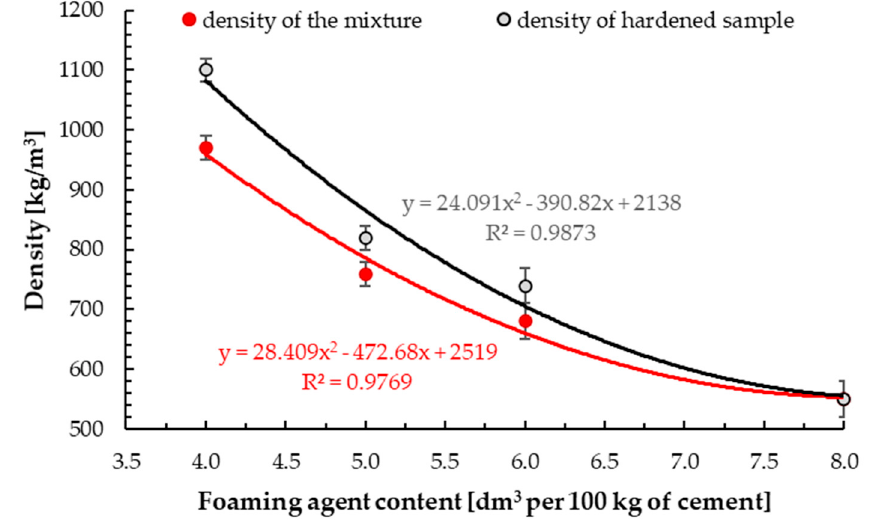
Figure 3. Density of the mixture and hardened samples with different content of foaming agent.